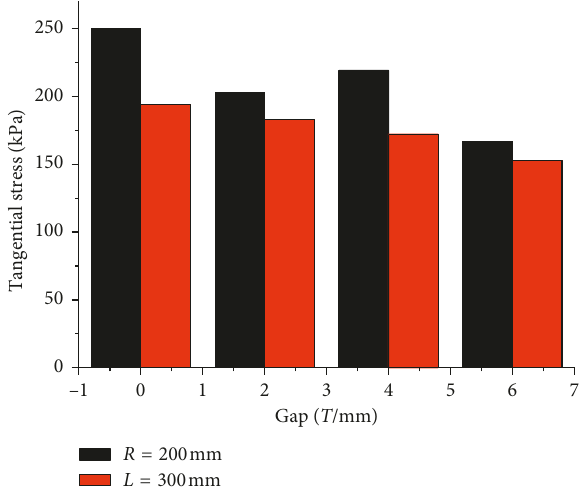
Figure 9: Comparison of tangential stress of different specimen sizes at a vertical stress of